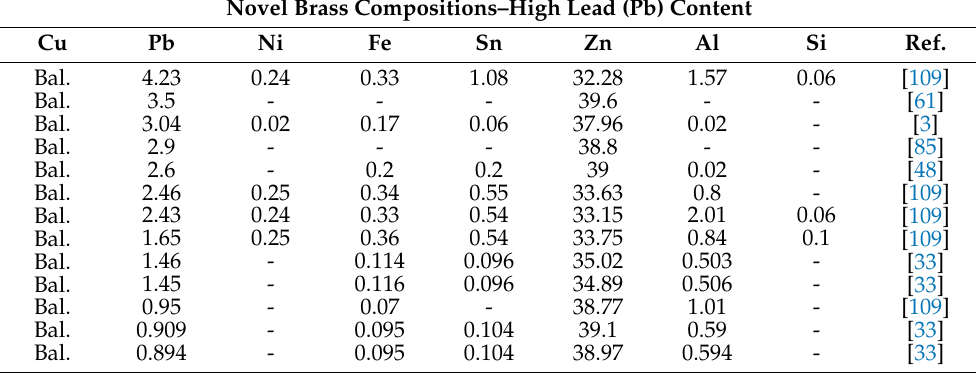
Table A4. Novel brass compositions with an increased lead (Pb) content (alloying elements expressed in